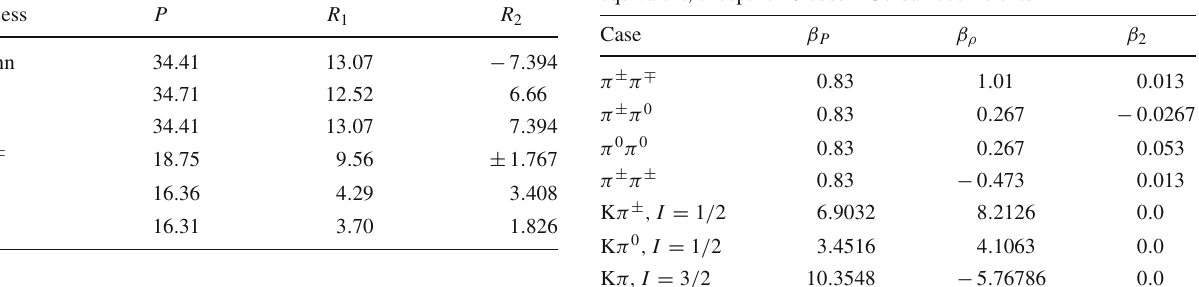
Table 3 Parameter values for the ππ and K π cross sections, as used in Eq. (16). In the case of K π , I refers to the sum of the third isospin components for the incoming particles. The two I = 1 / 2 cases are equivalent, except for Clebsch–Gordan